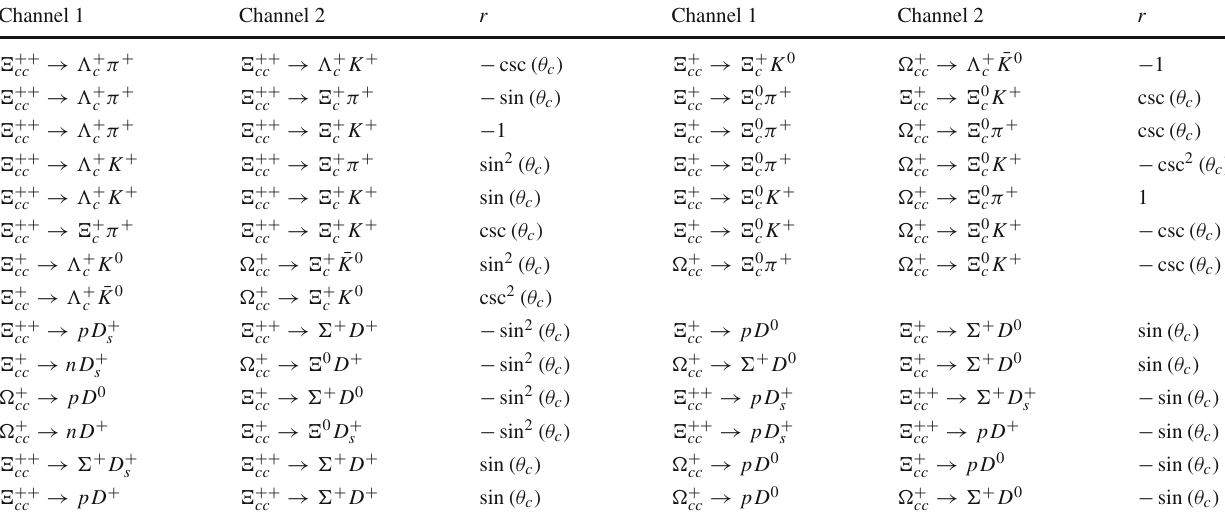
Table 9 Relations for Cabibbo-allowed, singly Cabibbo-suppressed and doubly Cabibbo-suppressed processes in Tables 5 and 7 Channel 1 Channel